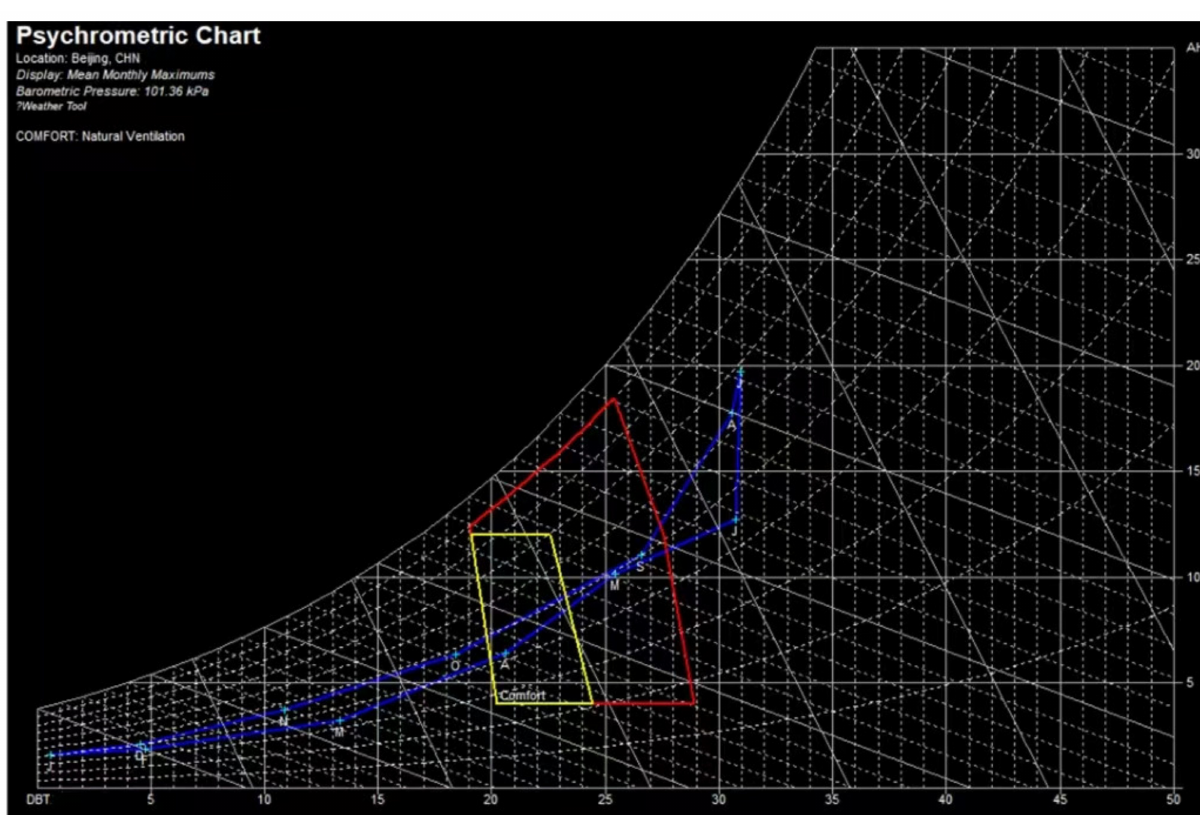
Figure 18. Enthalpy humidity